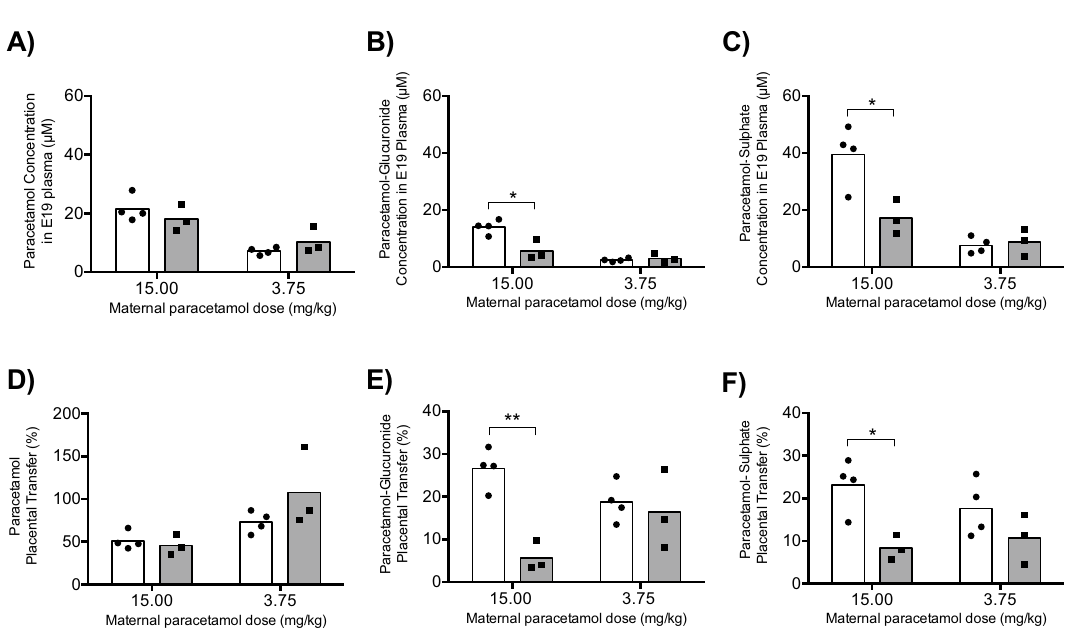
Figure 2. Levels of paracetamol and its metabolites in fetal and dam plasma. The concentration of paracetamol, paracetamol-glucuronide and paracetamol-sulphate in E19 plasma are shown in ( A–C ) respectively following 3.75 or 15 mg/kg acute (open bars) or chronic (grey bars) regimens. The placental transfer (%) between maternal and fetal circulation is shown for the three paracetamol structures in ( D–F ). Measurements were made using UPLC-MS/MS (see “Methods” section). Values from individual experiments are shown; n = 3–4. *p < 0.05; **p < 0.01.